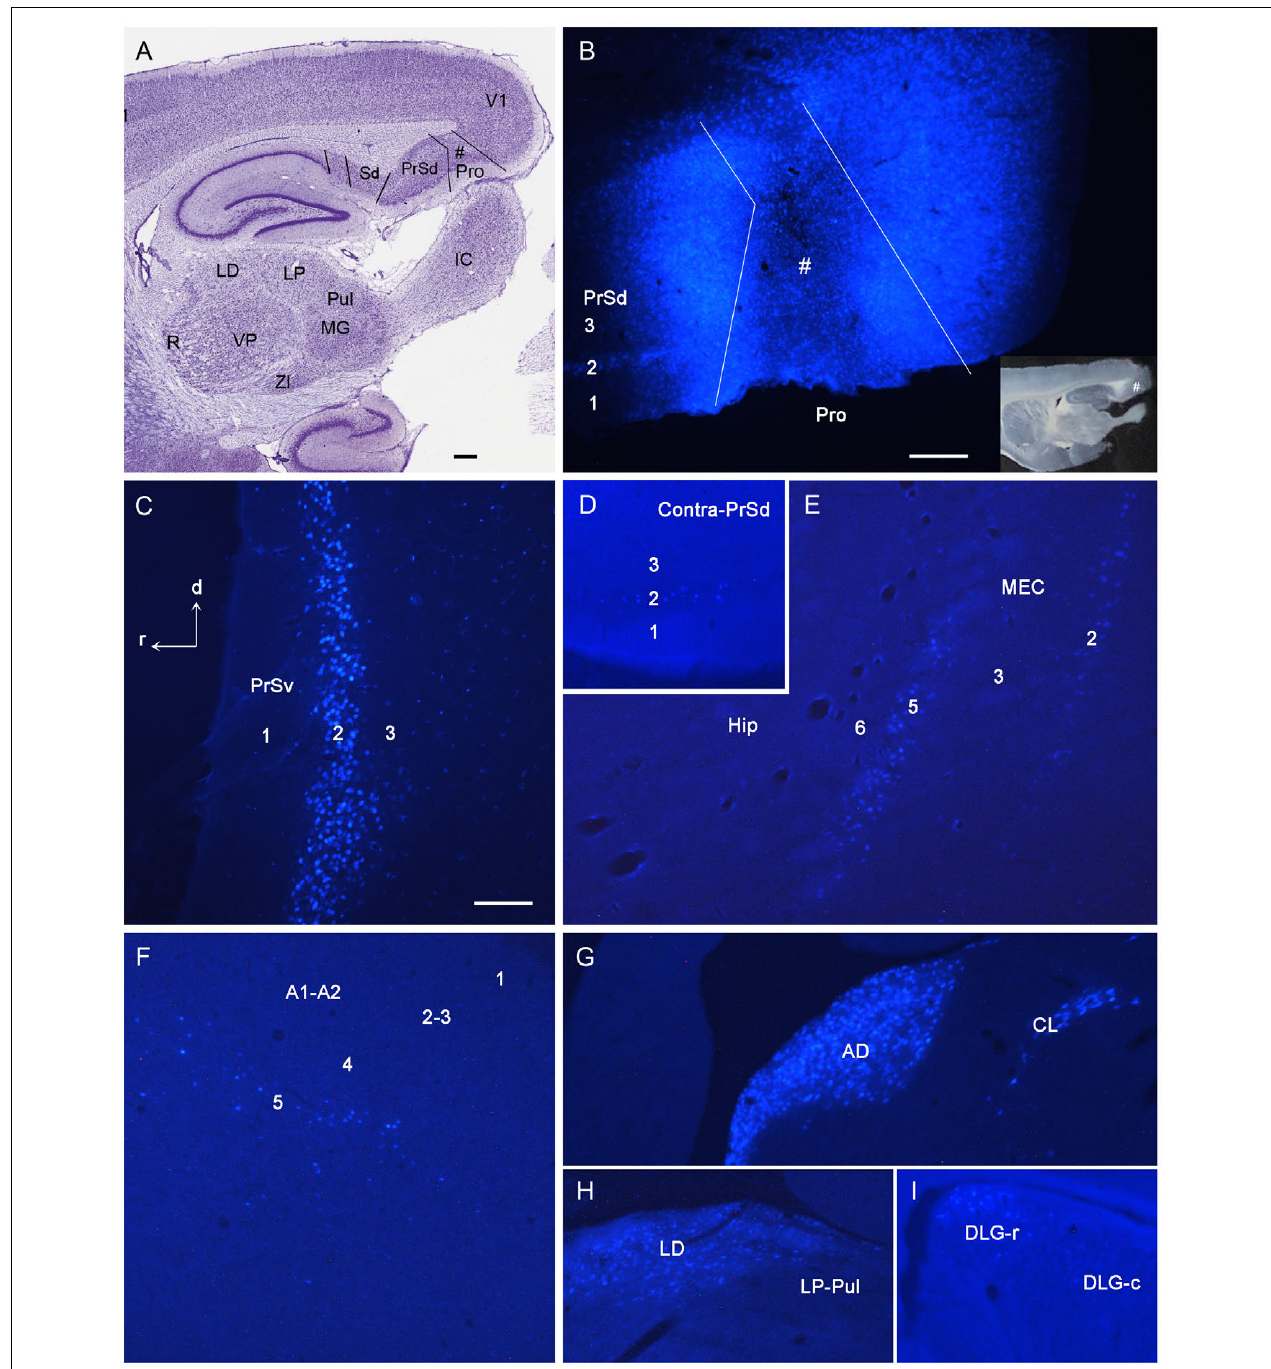
FIGURE 2 | Examples of retrogradely labeled neurons resulted from a Fluoro-Gold (FG) injection in rat prostriata. All panels are from sagittal sections. The dorsal [d] and rostral [r] orientation is shown in (C) for all panels. (A) A Nissl-stained section at the level of the injection (#) showing the locations of the prostriata (Pro) and nearby regions. (B) A fluorescent image showing the FG injection site (#) restricted to the prostriata. The inset (B) shows the same unprocessed section containing the injection sites. Note the retrogradely labeled neurons in layer 2 of PrSd. (C) FG retrogradely labeled neurons in layer 2 of PrSv. (D) FG-labeled neurons in layer 2 of contralateral PrSd. (E) FG-labeled neurons in layers 2 and 5 of medial entorhinal cortex (MEC). (F) FG-labeled neurons in layer 5 of the auditory cortex (both primary and secondary cortices, A1–A2). (G) FG-labeled neurons in anterodorsal (AD) and centrolateral (CL) nuclei of the thalamus. (H) FG-labeled neurons in laterodorsal thalamic nucleus (LD). Note the absence of labeled neurons in the lateroposterior nucleus–pulvinar complex (LP-Pul). (I) FG-labeled neurons in the rostral part of DLG (DLG-r). R, reticular thalamic nucleus; VP, ventroposterior thalamic nucleus; MG, medial geniculate nucleus; ZI, zona incerta; IC, inferior colliculus. Bars: 370 µ m (A) ; 100 µ m (C) ; 250 µ m (B) for (B,D–I)